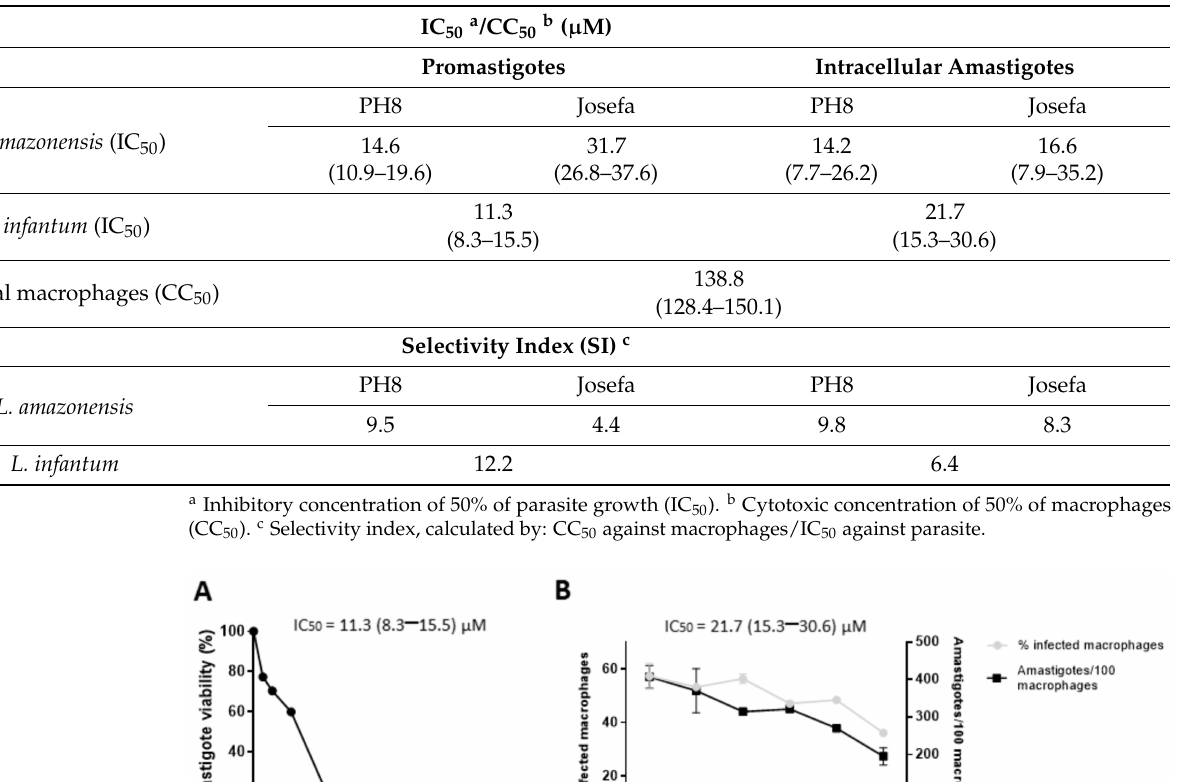
Table 1. TPCK effect on peritoneal macrophages, L. amazonensis and L. infantum promastigotes and amastigotes, and the selectivity index.